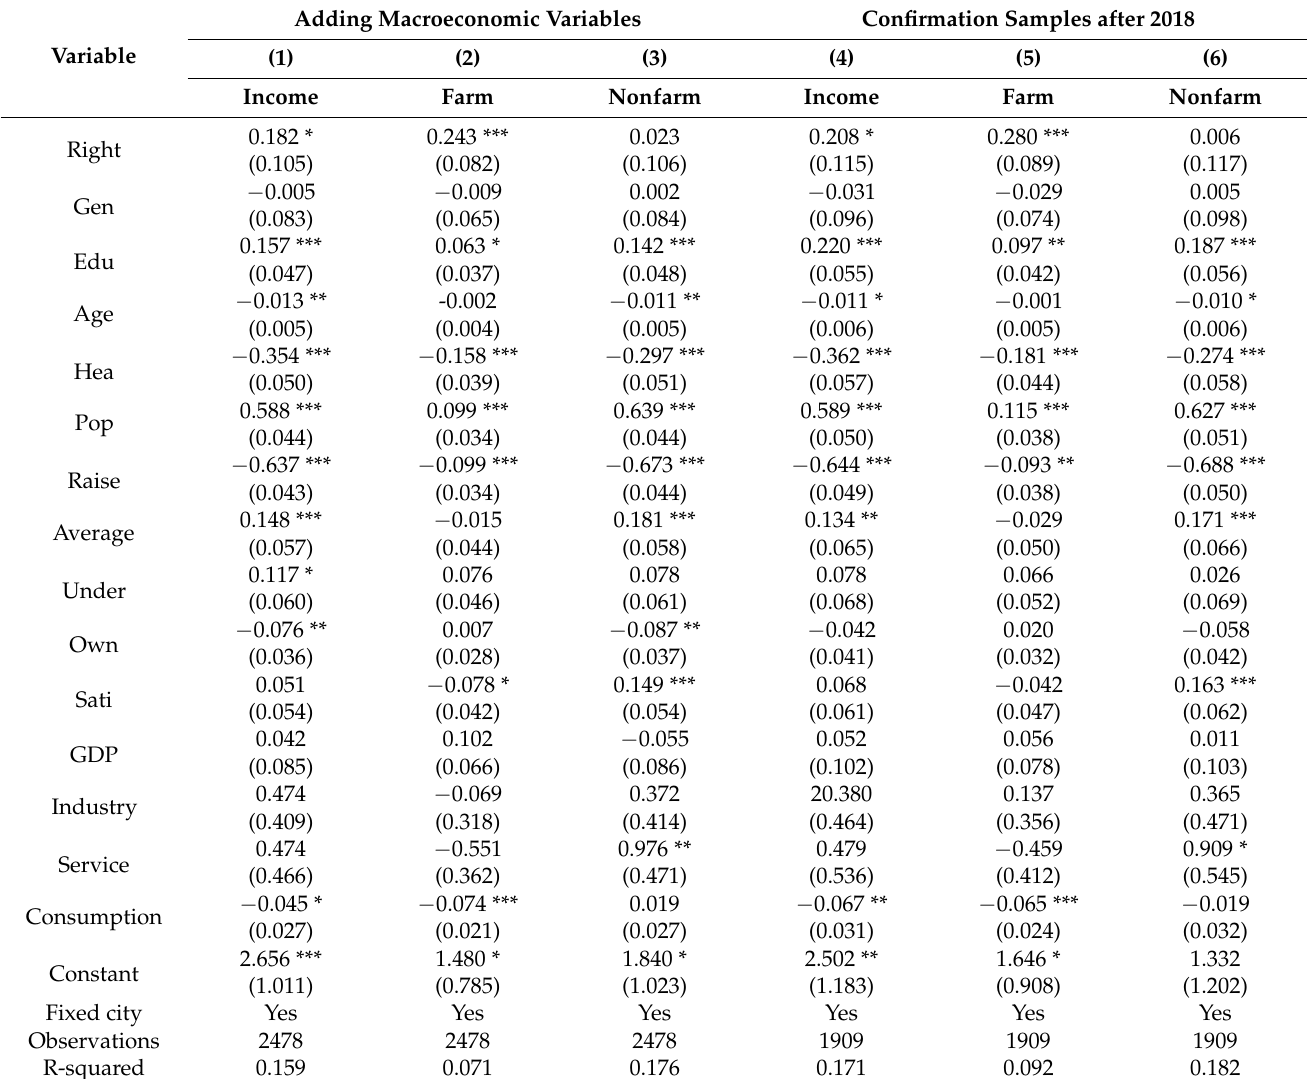
Table 5. Robustness test results of rural land right on farmers’